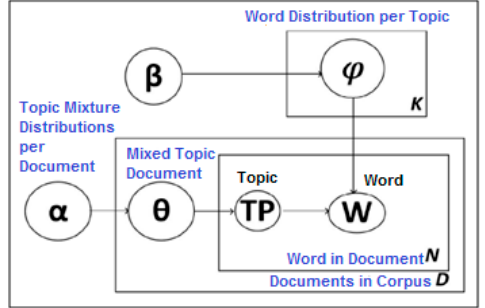
Figure 2. Graphical model representation of LDA.